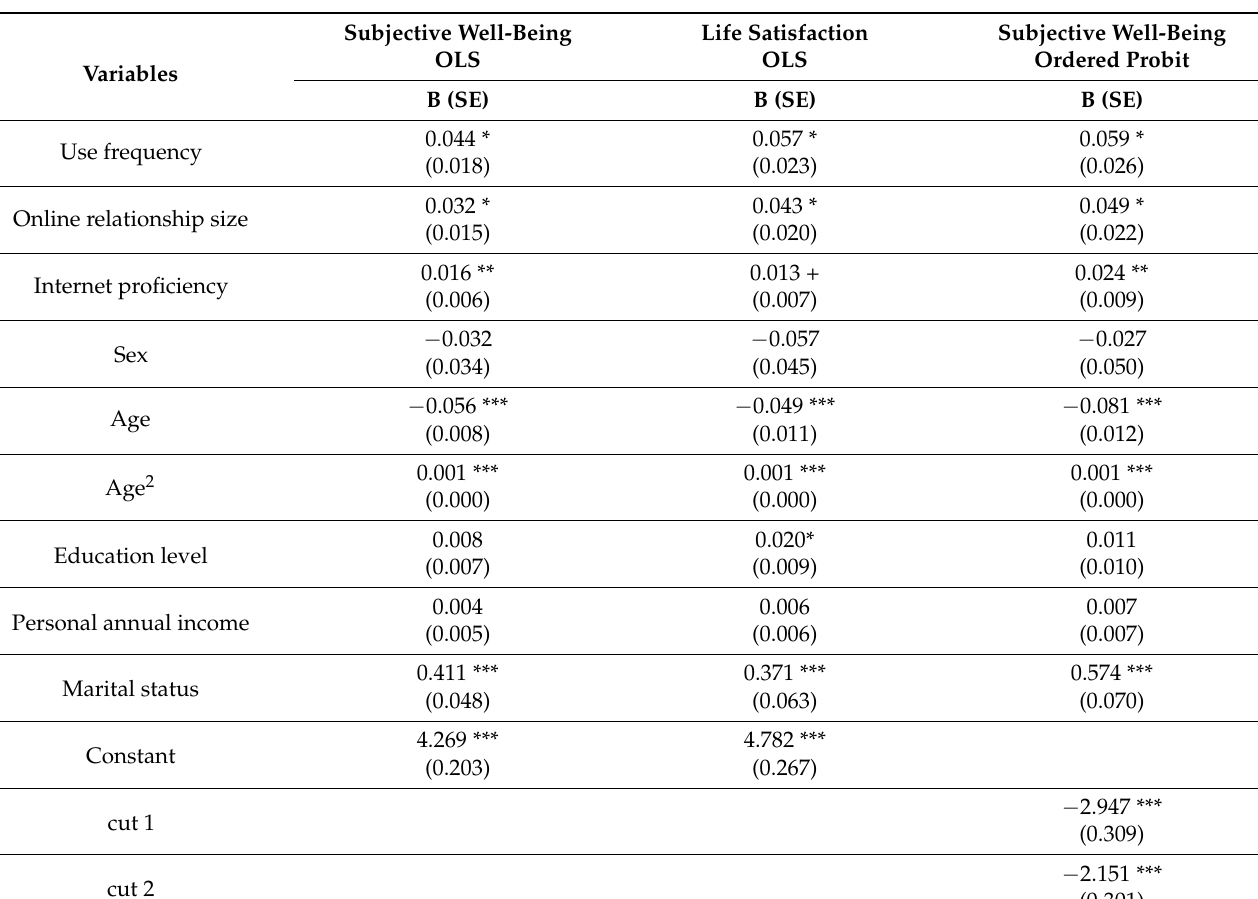
Table 3. Regression results for the robustness of the substituted explained variable and analysis model (N =